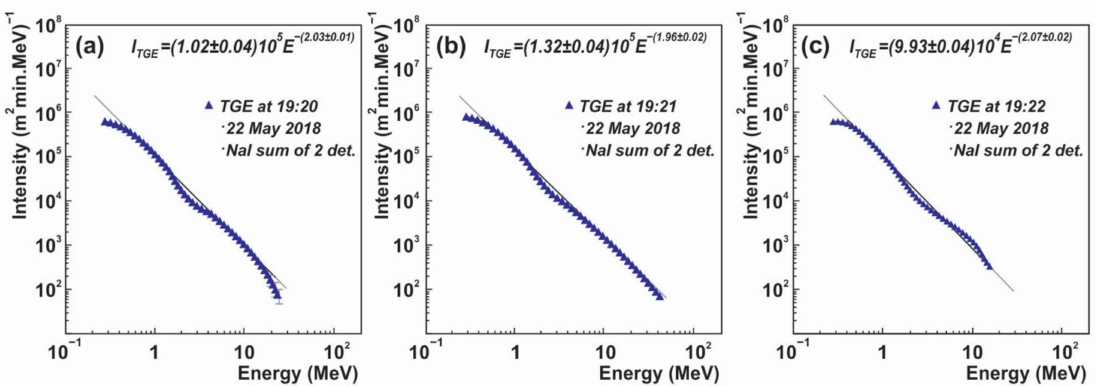
Figure 7. Differential energy spectra of TGE particles registered by NaI spectrometers at minutes of maximum